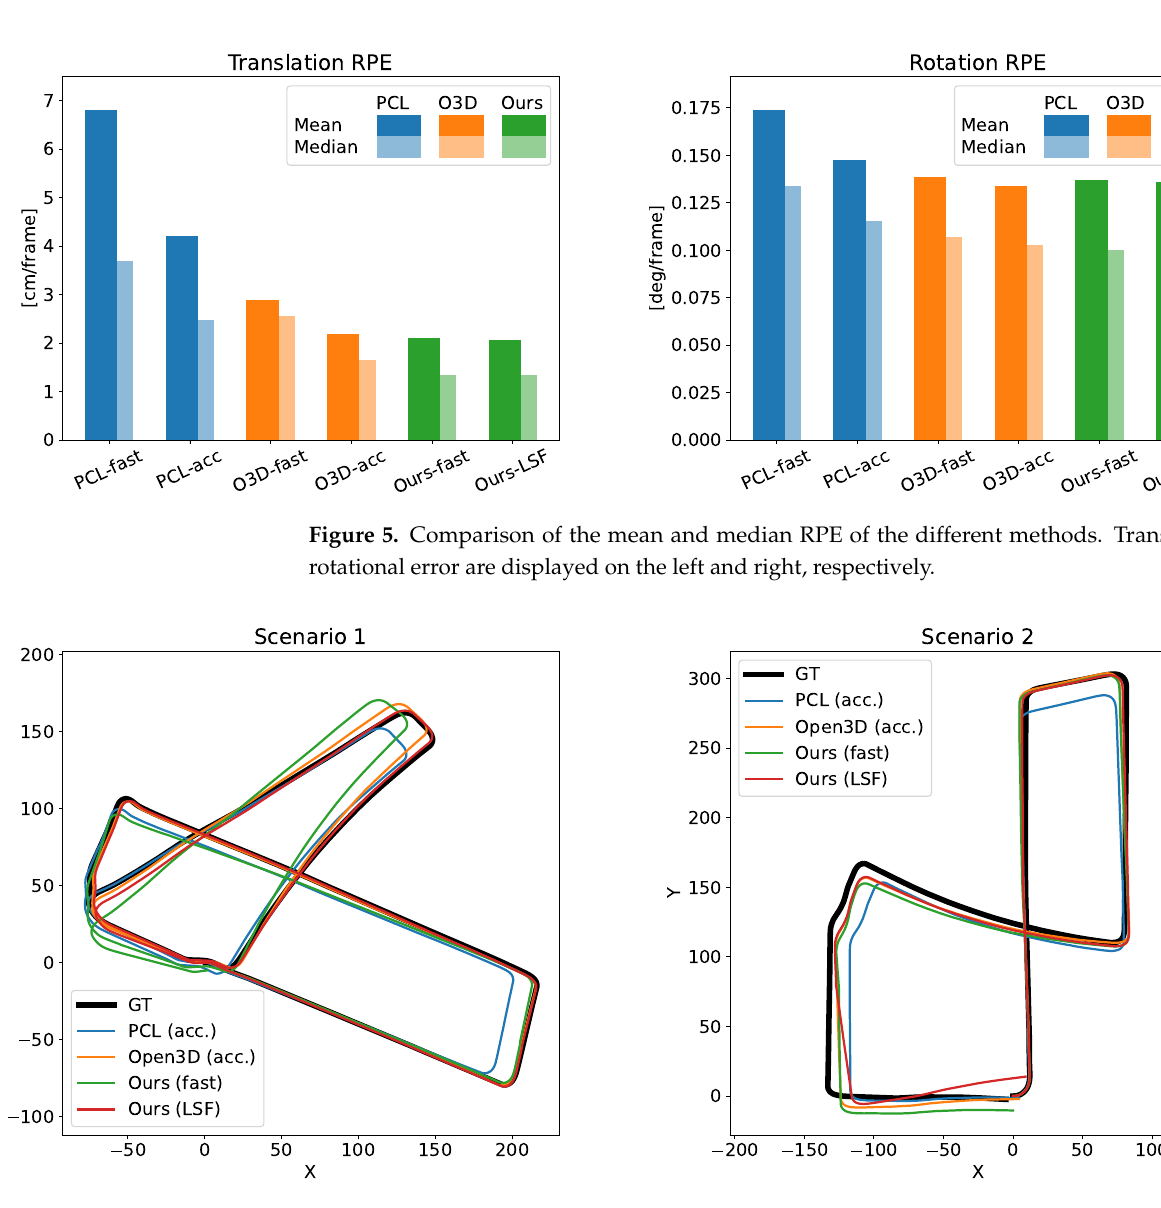
Figure 6. Top view of the resulting trajectories of the tested methods over each sequence of the dataset, along with the ground